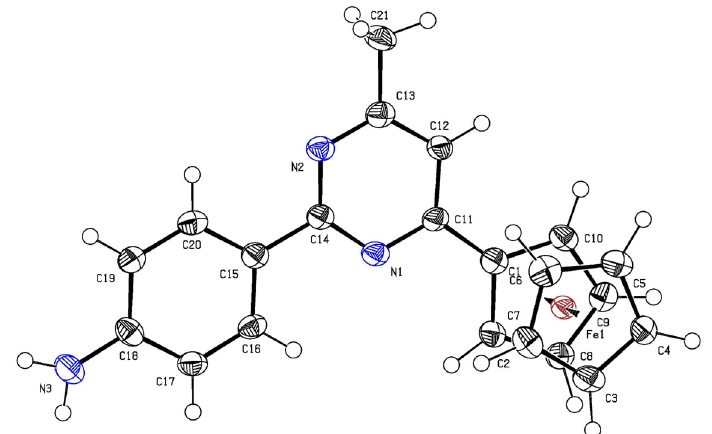
Figure 5. X-ray crystal structure of 8